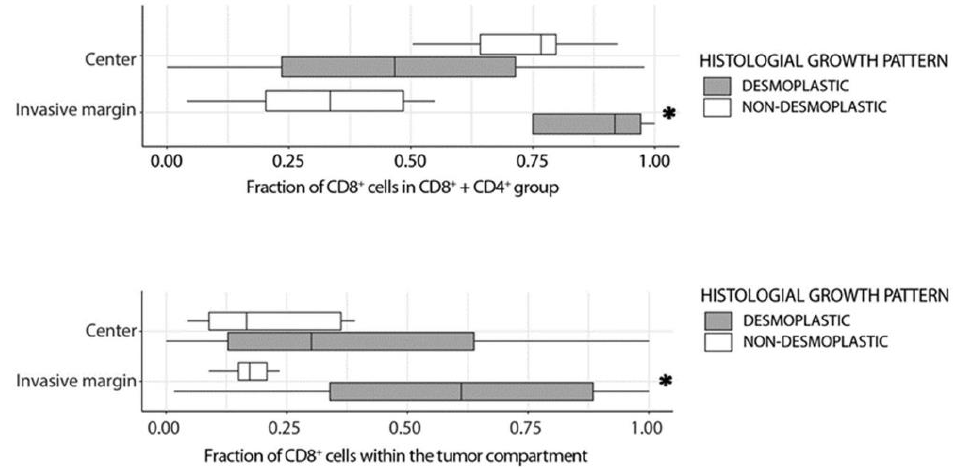
Figure 4. Top panel, boxplot for CD8/CD4 ratio comparing d HGP and nd HGP in central tumoral areas and at the invasive margin. Bottom panel, boxplot displaying the fraction of CD8 + cells within the epithelial compartment, both at the invasive margin and central tumor areas. Asterisks illustrate p value < 0.05, Mann–Whitney U test comparing d HGP vs. nd HGP.